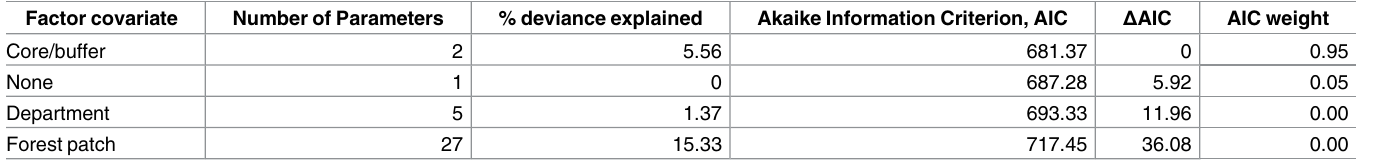
Table 1. Model fit and model selection results for zero–truncated Poisson regression models fit to group size data. Factor